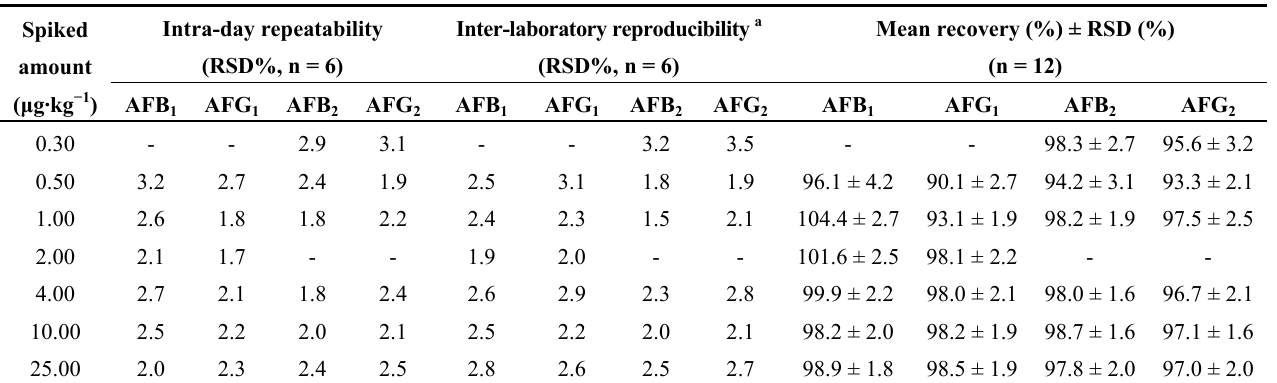
Table 2. Results for aflatoxins in validation study for peanut